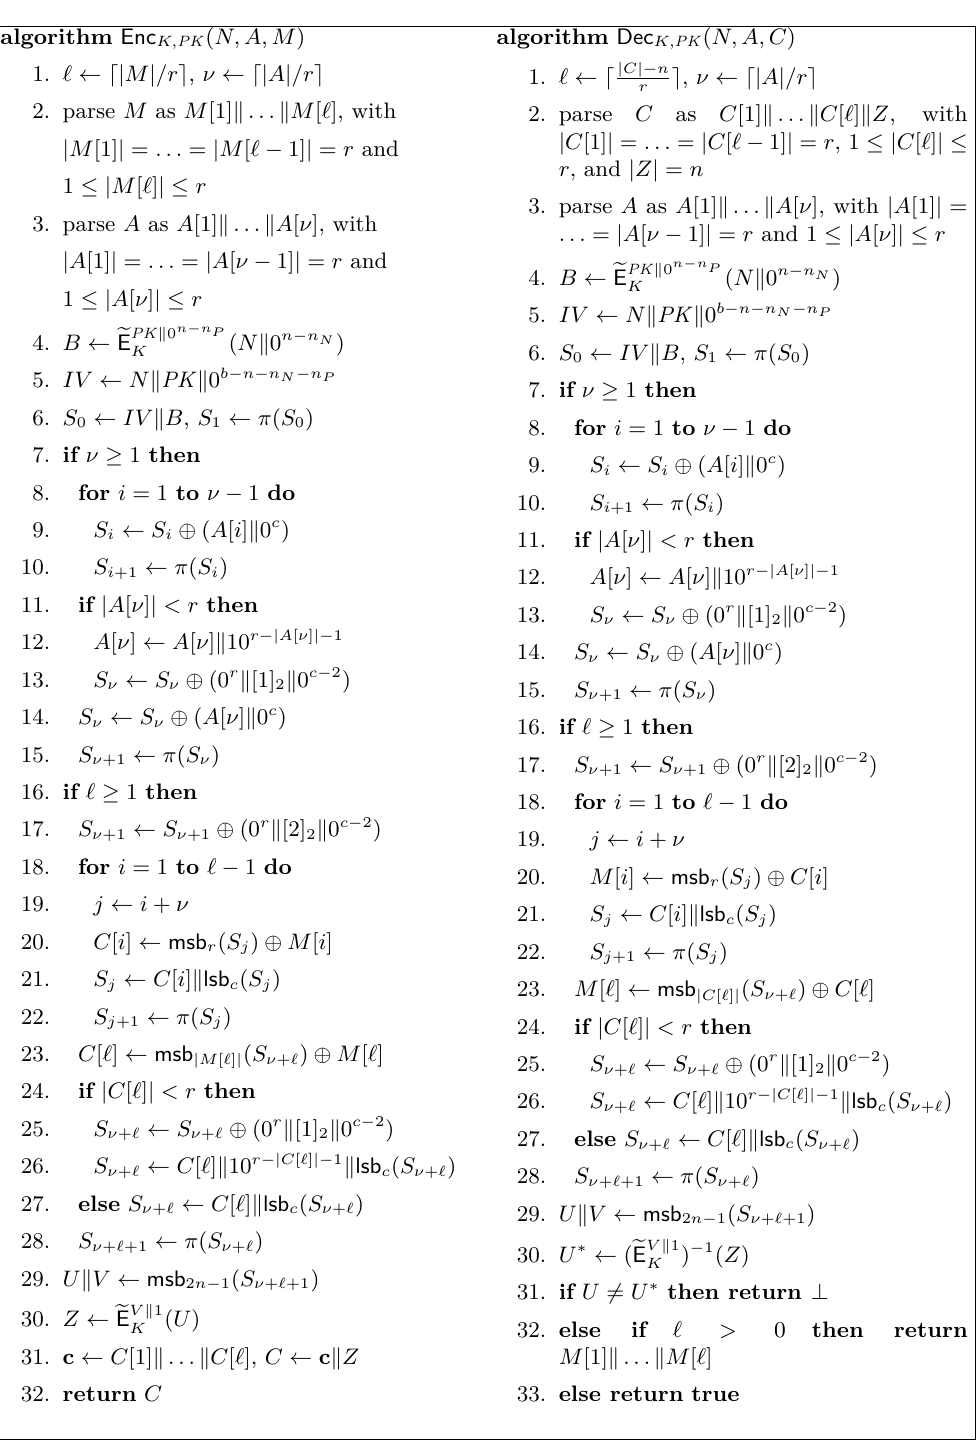
Figure 7: Specification of TETSponge [ π, e E ] using a b -bit permutation π and an ( n, n, n )- TBC e E